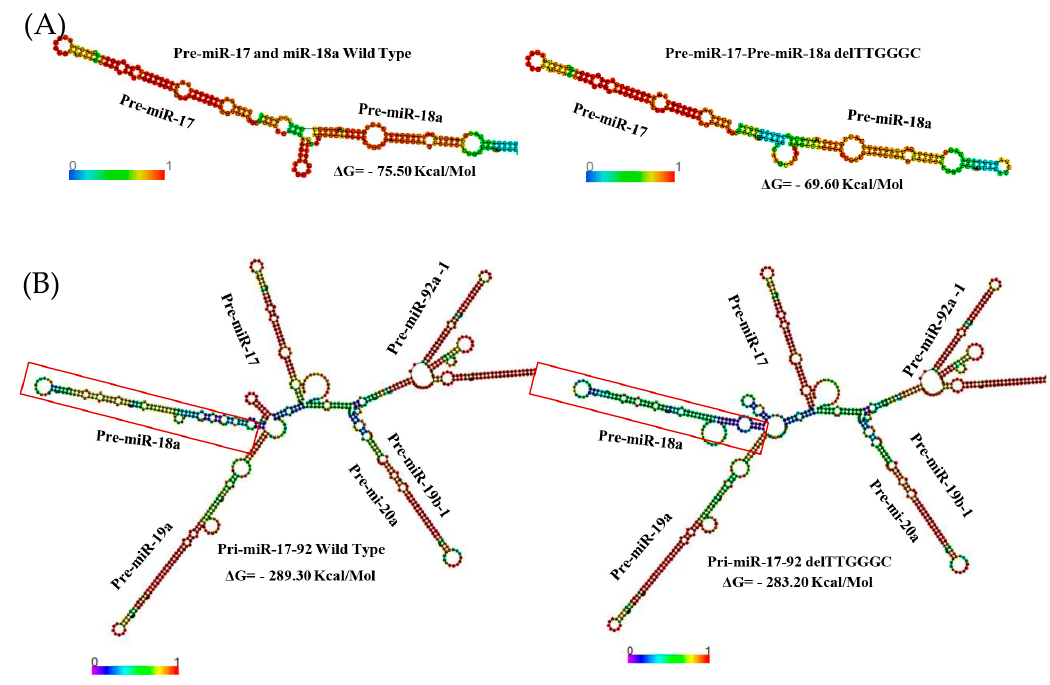
Figure 2. ( A ) Secondary RNA structure predictions for wild-type and delTTGGGC pre-miR-17–pre-miR-18 sequences, using an RNAfold algorithm. Color bars represent base-pair probabilities. ( B ) Secondary RNA structure predictions for wild-type and delTTGGGC polycistronic pri-miR 17–92 cluster sequences, using an RNAfold algorithm. Color bars represent base-pair probabilities. Red boxes depict changes in pre-miR-18a hairpin.